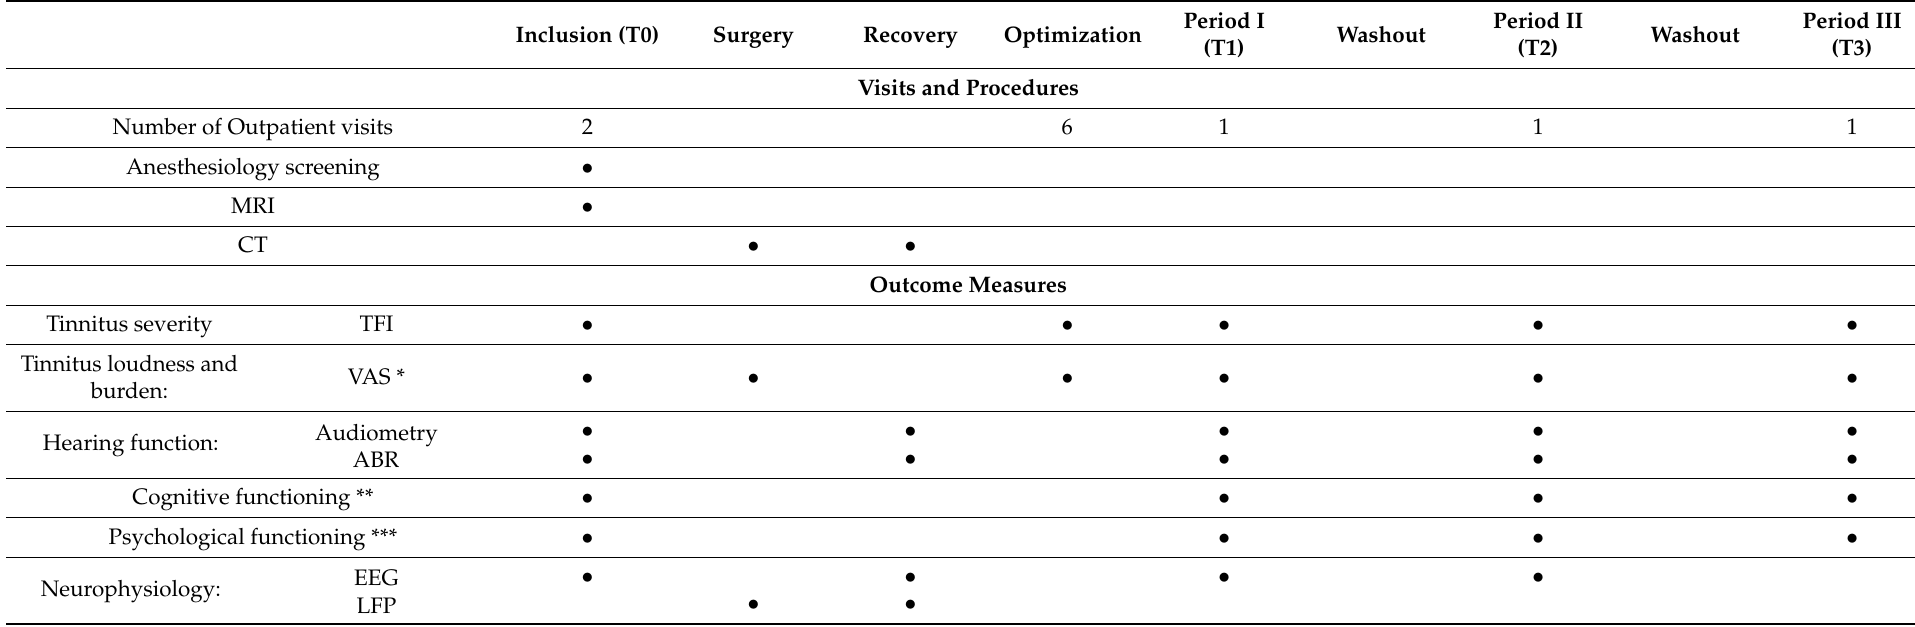
Table 3. Schedule of assessments and procedures. T0 is at inclusion. T1 is at the end of the first 6-week treatment period (stimulation ON or OFF). T2 is at the end of the second 6-week treatment period (stimulation OFF or ON). T3 is at the end of the third treatment period of 6 months stimulation ON. MRI, Magnetic Resonance Imaging; CT, Computer Tomography; TFI, Tinnitus Functional Index; VAS, Visual Analogue Scale; ABR, Auditory Brainstem Responses; EEG, Electroencephalography; LFP, Local Field